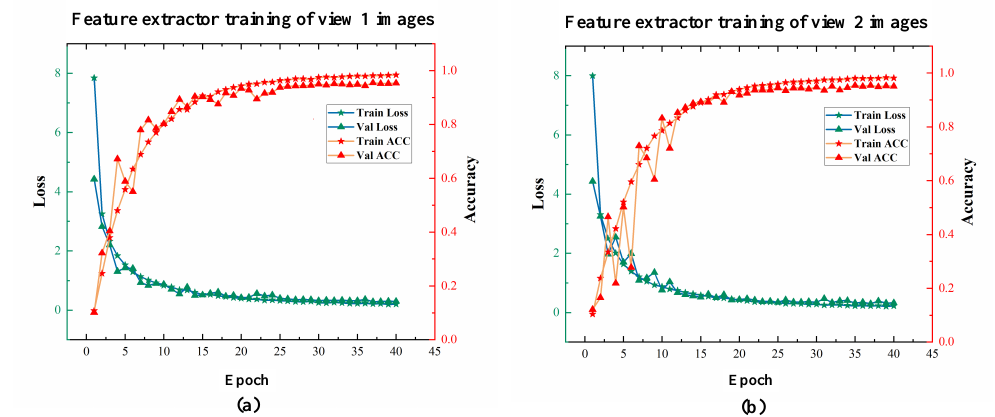
Figure 10. The training process curve of feature extractor based on ResNet34. ( a ) represents view 1, ( b ) is view